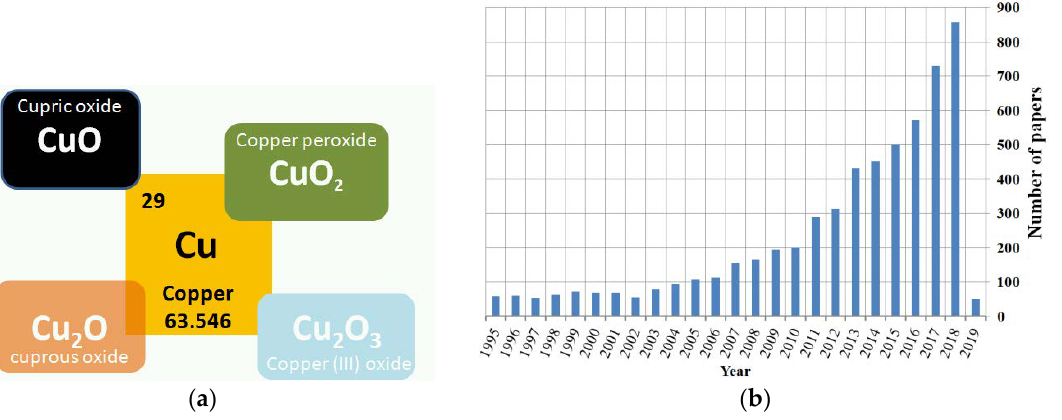
Figure 1. The copper oxides: ( a ) schematic view of the possible copper oxide forms and ( b ) the number of papers related to CuO-based gas sensors from 1995–2019.